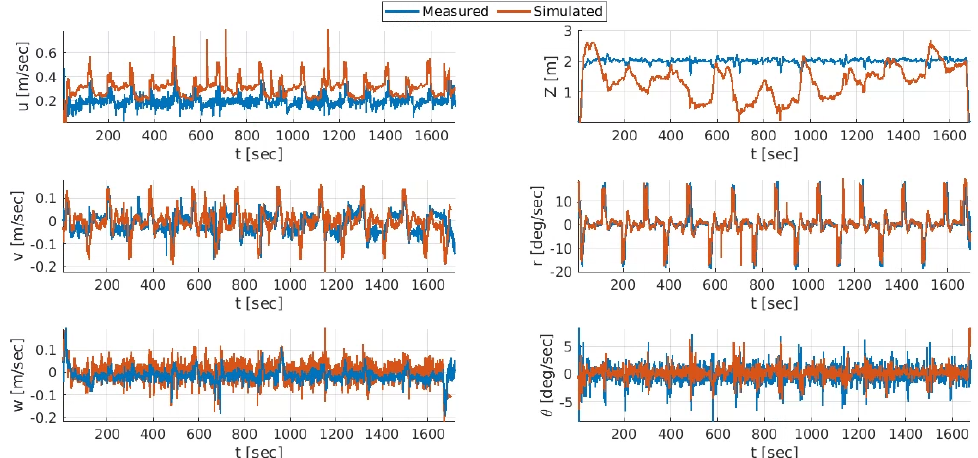
Figure 8. Comparison between the vehicle’s dynamic response, as computed by the calibrated model and the actual response, as measured at sea for surge ( top left ), sway ( middle left ), heave ( bottom left ), depth ( top right ), yaw rate ( middle right ) and pitch ( bottom right